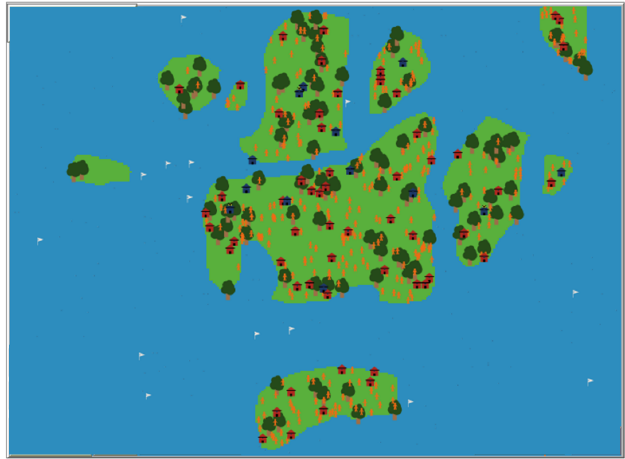
Figure 14. Map imported to Netlogo of the Bahía Málaga